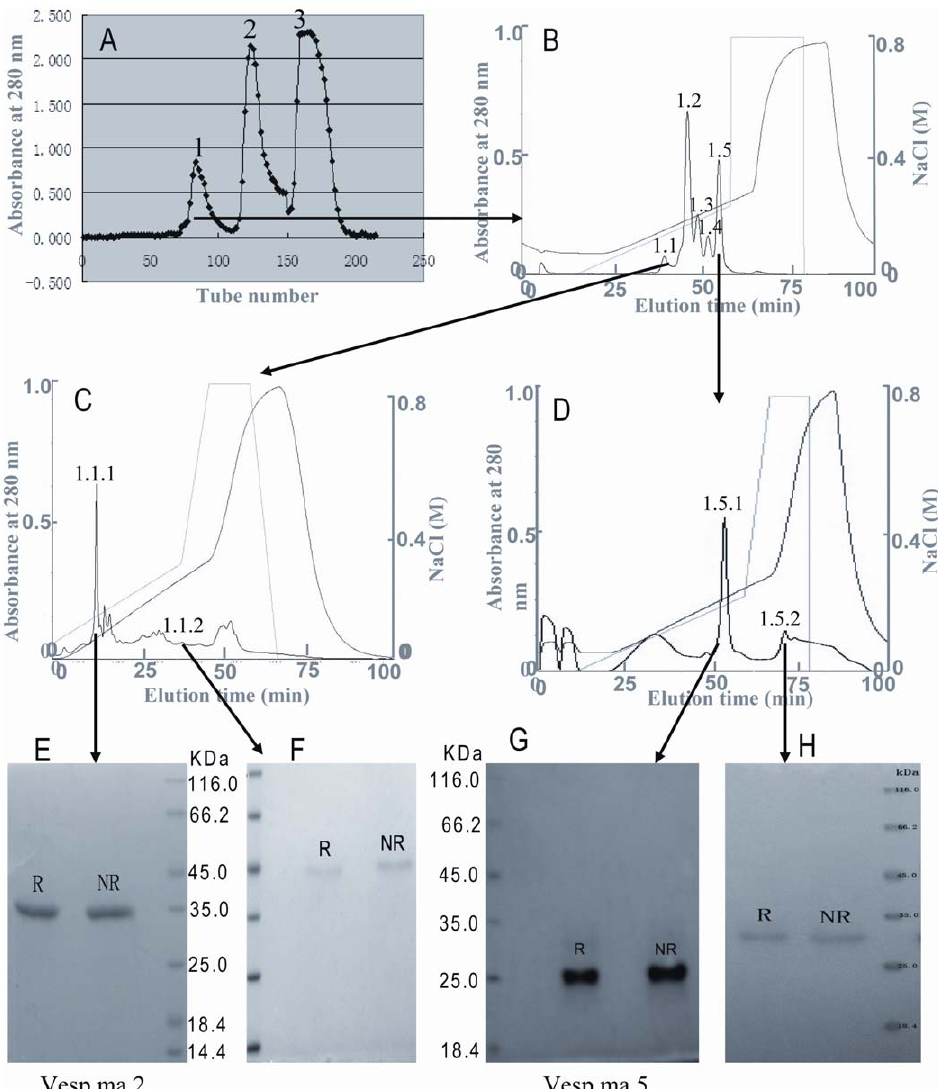
Figure 1. Purification of allergens from the wasp venoms (WV), V.magnifica . A: WV aliquot of 0.2 g was applied to a Sephadex G-75 gel filtration. The absorbance of the eluate was monitored at 280 nm. B : Fraction 1 from Sephadex G-75 gel filtration was subjected to AKTA Resource S cationic exchange chromatography. The elution was performed at a flow rate of 1 ml/min with the indicated NaCl gradient. C : The first protein peak after Resource S cationic exchange chromatography (peak 1.1) was subjected to AKTA Mono S cationic exchange chromatography. The elution was performed at a flow rate of 1 ml/min with the indicated NaCl gradient. D : The fifth protein peak after Resource S cationic exchange chromatography (peak 1.5) was subjected to AKTA Mono S cationic exchange chromatography. The elution was performed at a flow rate of 1 ml/min with the indicated NaCl gradient. E & F : SDS-PAGE analysis of purified allergens of Vesp ma 5 and Vesp ma 2 in 15% gel concentration. R: reduced; NR: non- reduced.